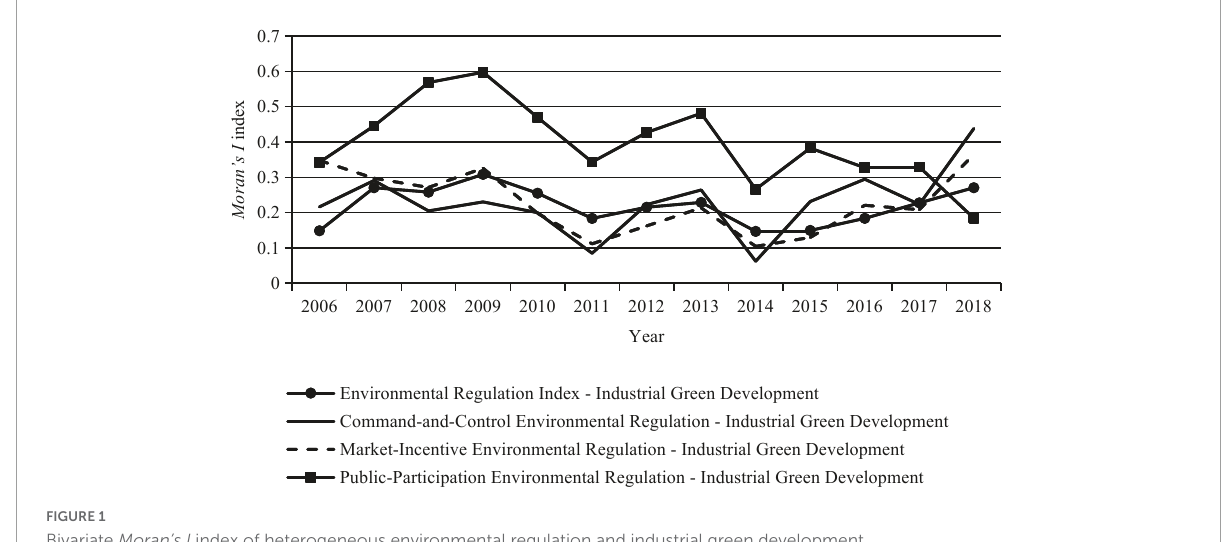
FIGURE1 Bivariate Moran’s I index of heterogeneous environmental regulation and industrial green development.